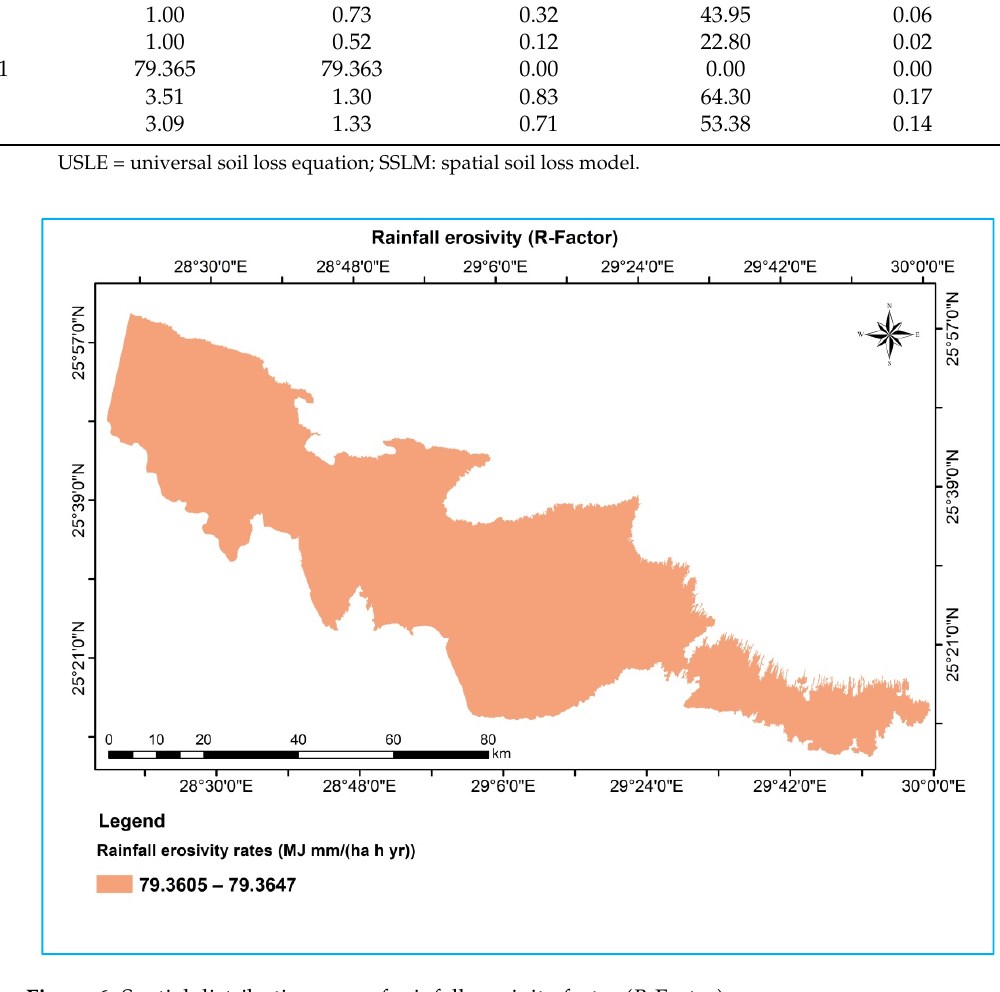
Figure 6. Spatial distribution map of rainfall erosivity factor (R-Factor). Table 11. Descriptive data on the rates of USLE factors, the USLE model, and SSLM.